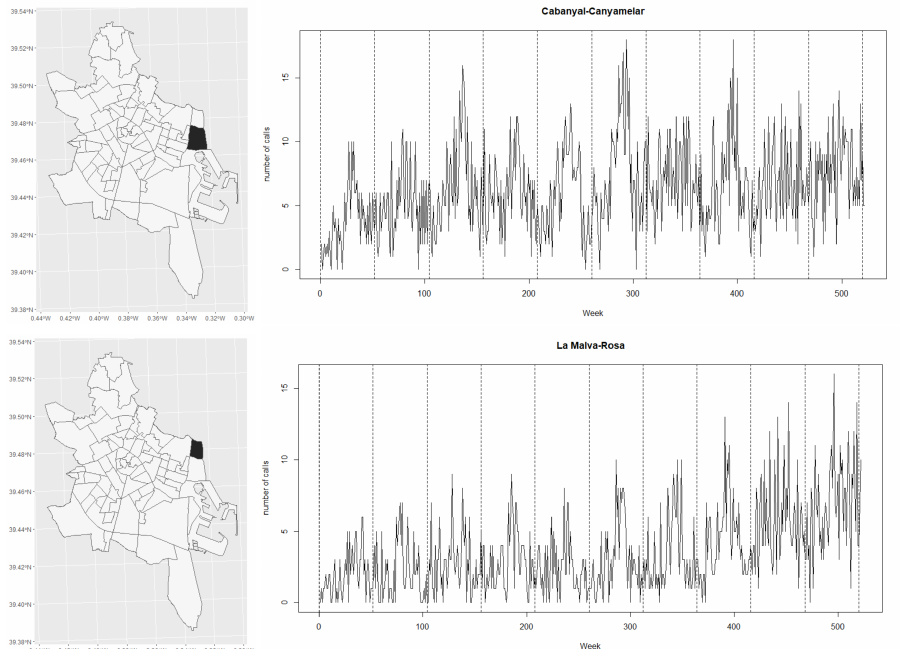
Figure 4. Weekly calls distribution over time at maritime districts in Valencia, Cabanyal-Canyamelar (top row), and Malva-Rosa (bottom